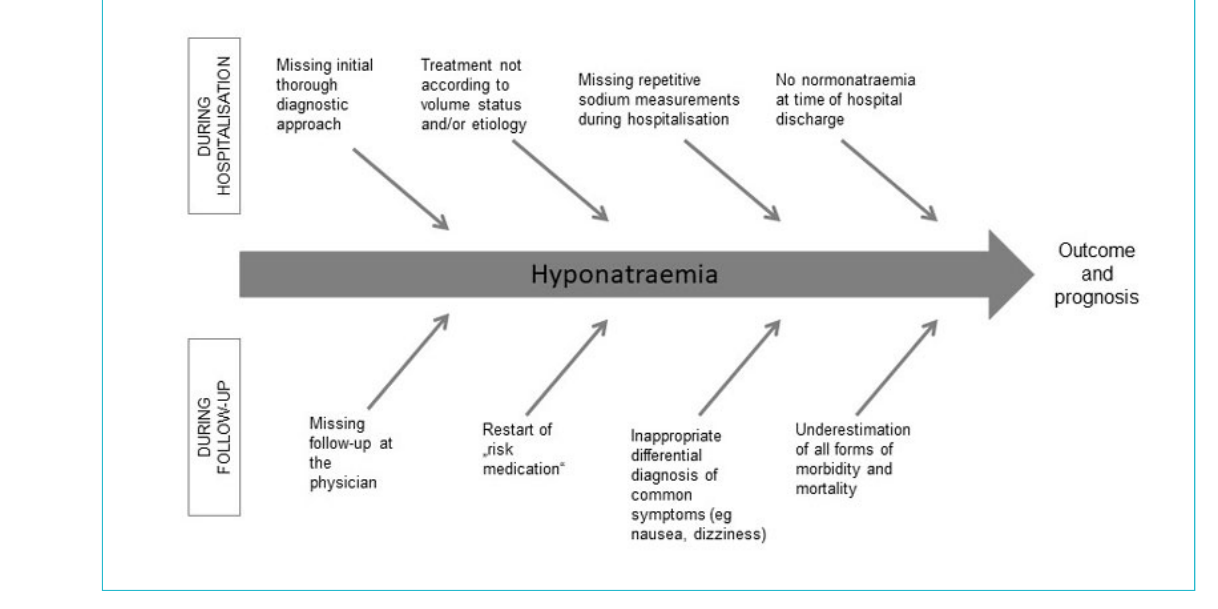
Figure 4: Effects on outcome and prognosis of